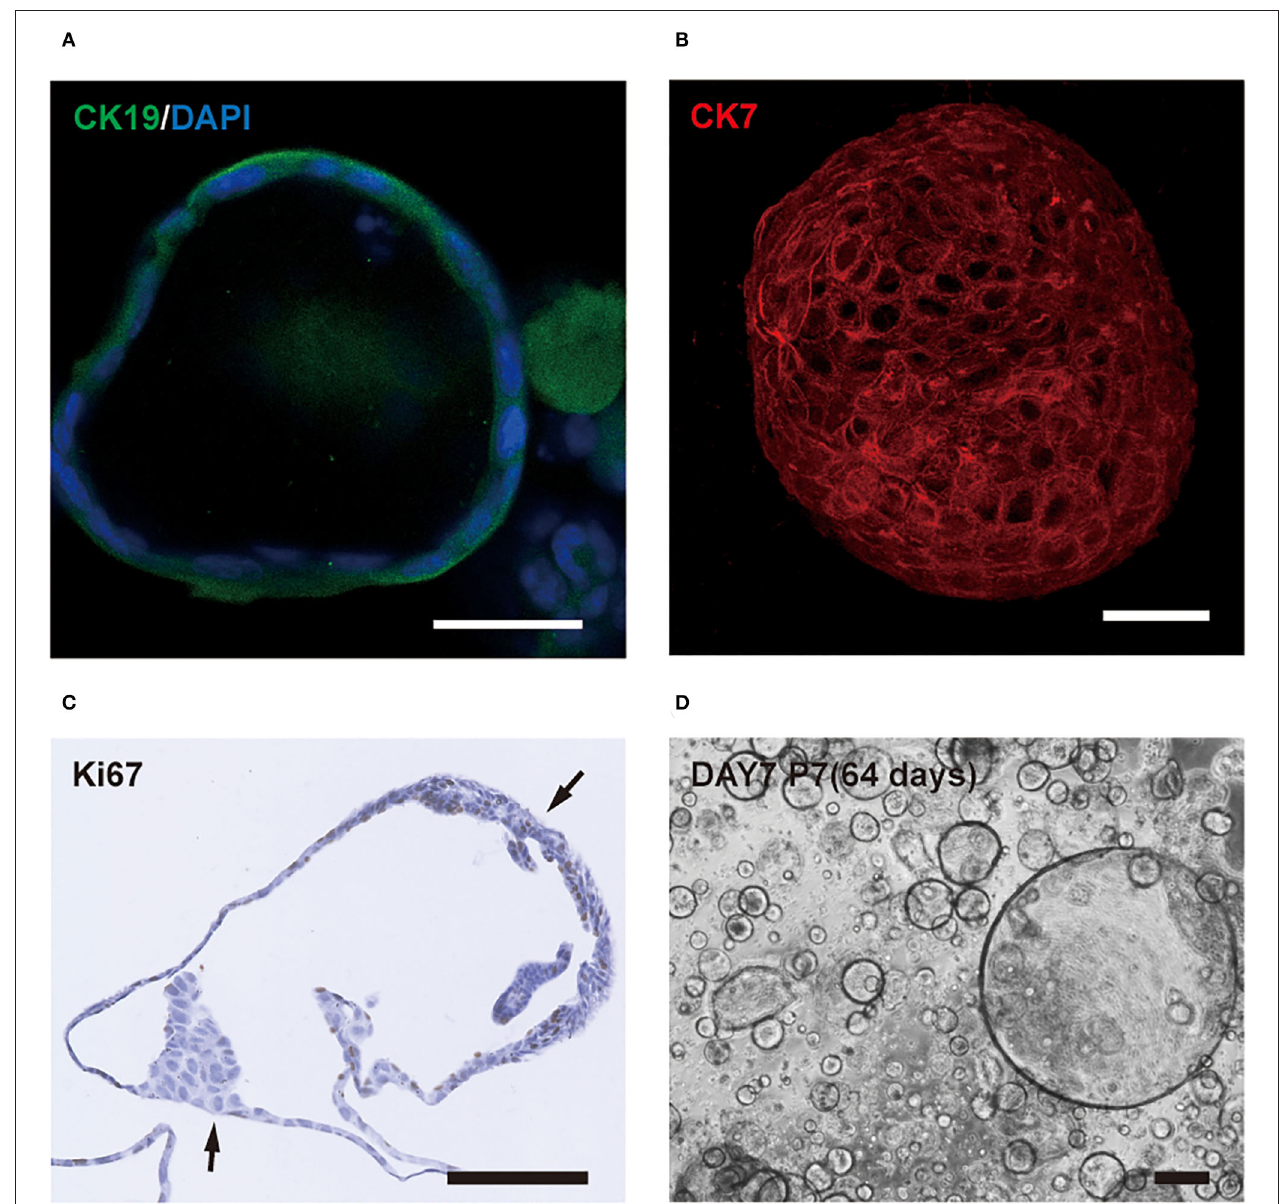
FIGURE 4 | Characteristics of cholangiocytes-organoids (cho-orgs). (A) Immunofluorescence staining for the cholangiocyte marker CK19 (green) (bar, 100 µ m). (B) Immunofluorescence staining for CK7 (red) in a 3D structure (bar, 100 µ m). (C) The cho-orgs consisted of more than one cell layer and express the proliferation marker Ki67 (bar, 100 µ m). (D) The cho-orgs from intrahepatic bile ducts were cultured for 7 days after seeding and passaged seven times for a total culture duration of > 64 days (bar, 200 µ